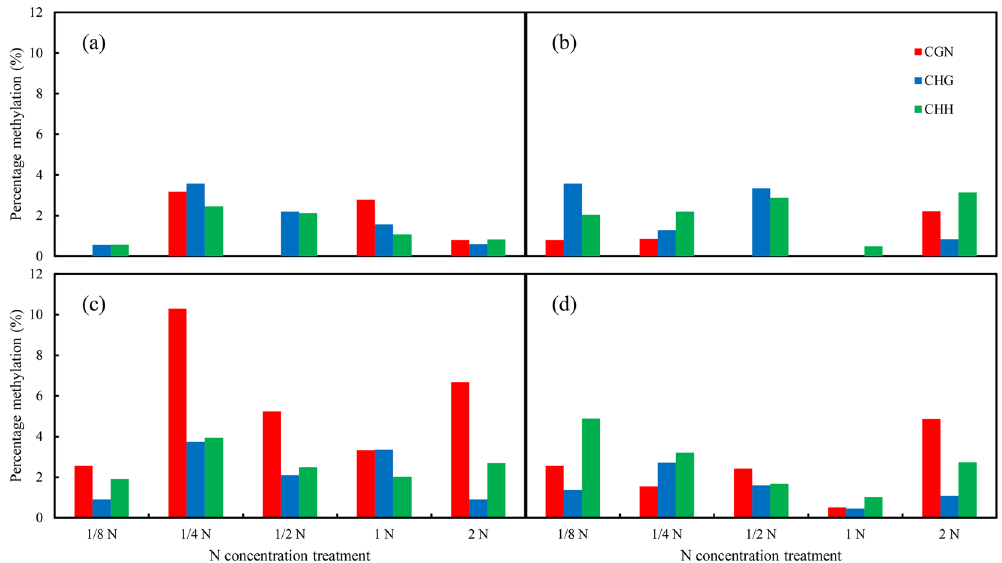
Figure 7. Percentage methylation of different methylation patterns (CGN, CHG and CHH) in P1 ( A , B ) and P2 ( C , D ) fragments of the fused Cry 1Ab/Ac transgene in leaves of transgenic Bt rice grown under ambient ( A , C ) and elevated ( B , D ) CO 2 with different N-fertilizer